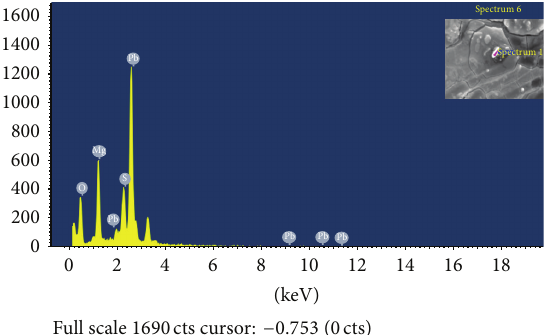
Figure 5: EDS analysis for elemental composition of lead on cell surface of isolate B. cereus NSPA8. ∗ Inset-bacterial cell surface selected for EDS analysis.